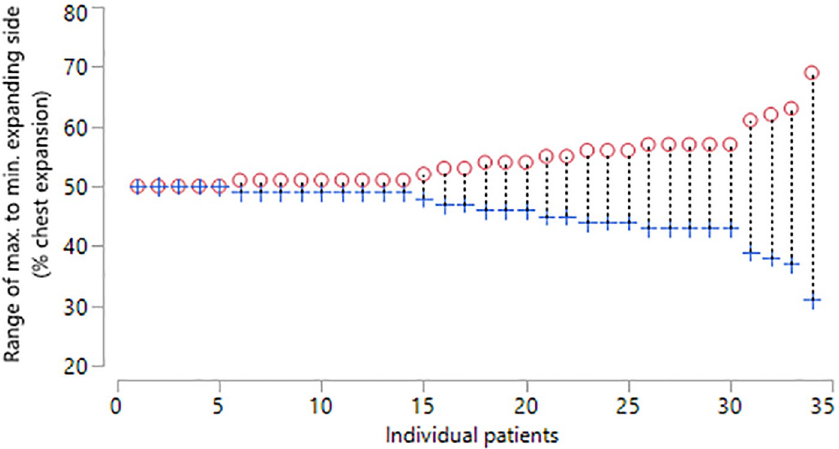
Fig 6. Percentage right and left thoraco-abdominal contributions for patients (n = 34) during one minute of tidal breathing. Circle = maximal expanding side, Cross = minimal expanding side.